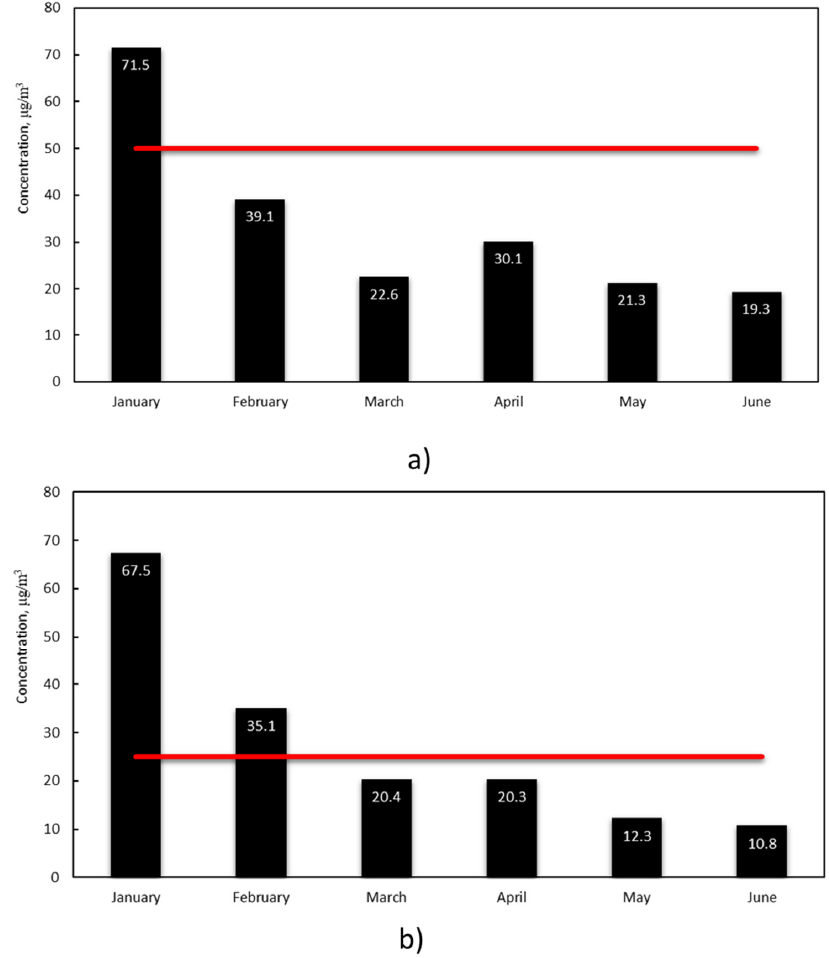
Figure 13. ( a ) PM10 average monthly concentrations measured by the ROM network in Milan in the months of January–June 2020. PM10 daily law limit according to D.Lgs 155/2010 (red solid line). ( b ) PM2.5 average monthly concentrations measured by the ROM network in Milan in the months of January–June 2020. PM2.5 daily law limit according to D.Lgs, 155/2010 (red solid line). Table 2. Ranking of the worst 4 NILs for the months January–April